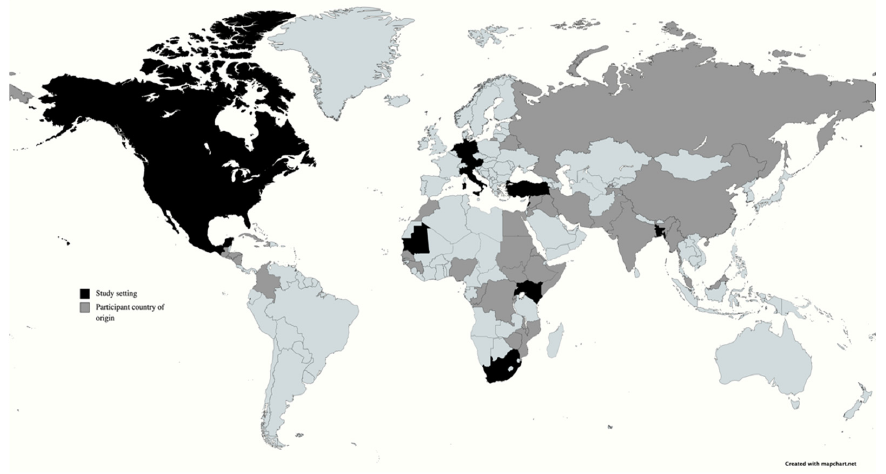
Figure 3. World map representing setting of studies (black) and country of origin of participants